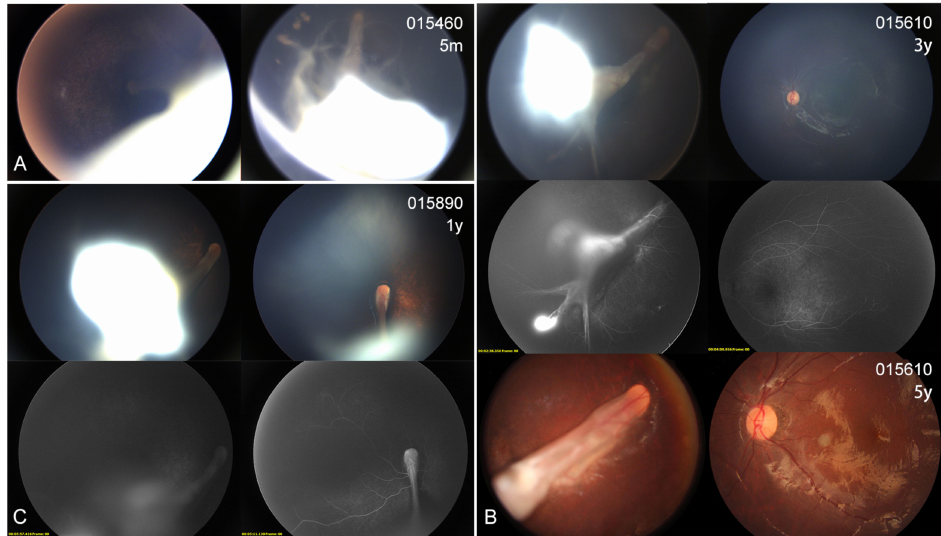
Figure 3. Color fundus (CF) and fluorescein angiography (FA) images of probands with KIF11 variants. ( A ) CF photographs of patient 015460 show bilateral tractional retinal detachment (RD) in both eyes. ( B ) CF and FA photographs of patient 015610 show a retinal fold (RF) involving the macula, tractional RD, and chorioretinal dysplasia in the right eye and peripheral avascular zones in the left eye. At the 2-year follow-up, the lesions appeared stable. ( C ) CF and FA images of patient 015890 show bilateral RFs and tractional RD in both eyes, in keeping with diffuse chorioretinal dysplasia.